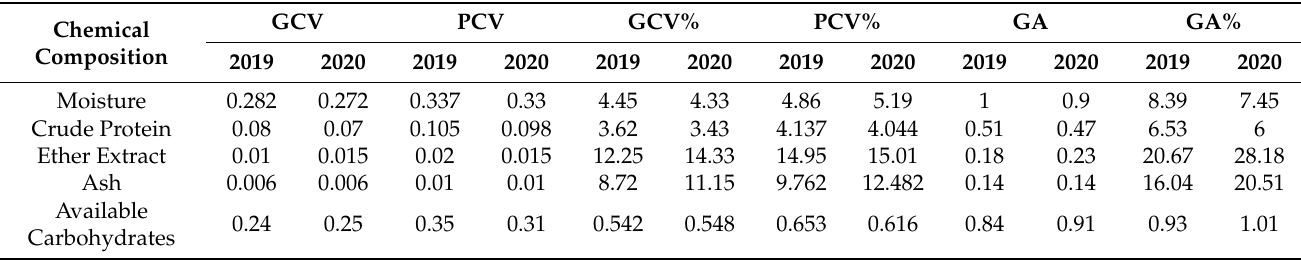
Table 9. Estimates of variability parameters for chemical composition (%) of milled rice of the studied genotypes during the 2019 and 2020 growing